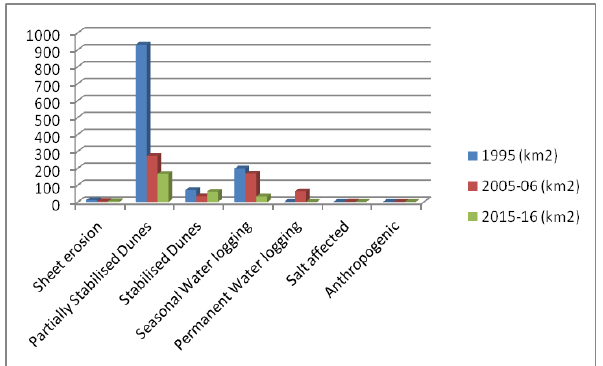
Figure 1. Graph depicting change in area of degraded